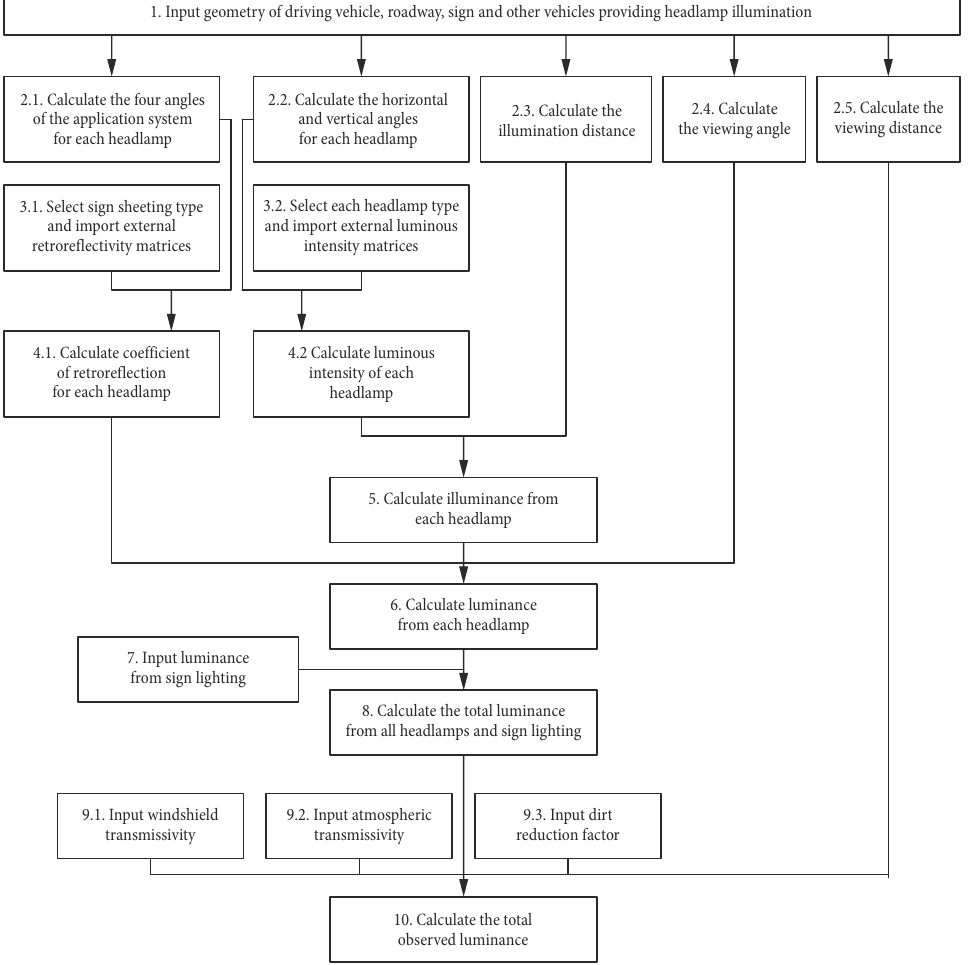
Fig. 2. Flow chart of calculation procedures in the luminance computation model